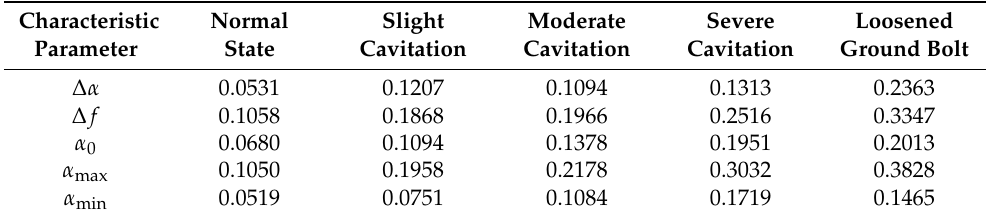
Table 2. Characteristic parameters of the vibration signals of the centrifugal pump.